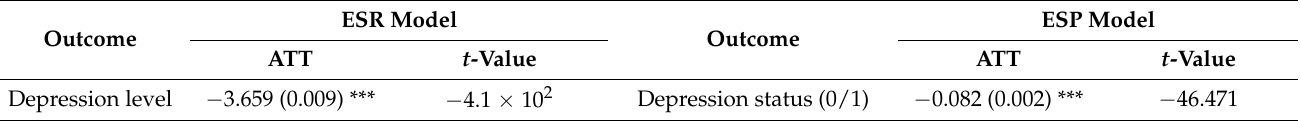
Table 5. Average treatment effects on treated using ESR and ESP model.